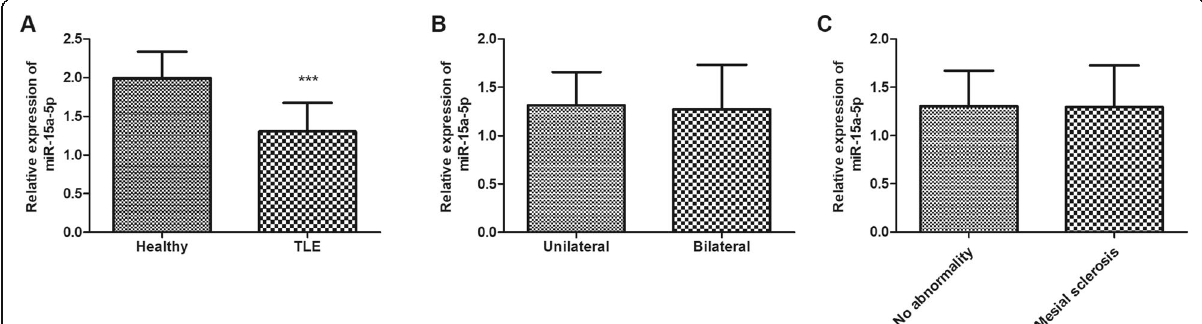
Fig. 1 The expression level of miR-15a-5p in the serum of children with temporal lobe epilepsy (TLE) and healthy controls. a . The TLE children had significantly low expression of miR-15a-5p compared with healthy group. b . There was no significance for miR-15a-5p expression in bilateral